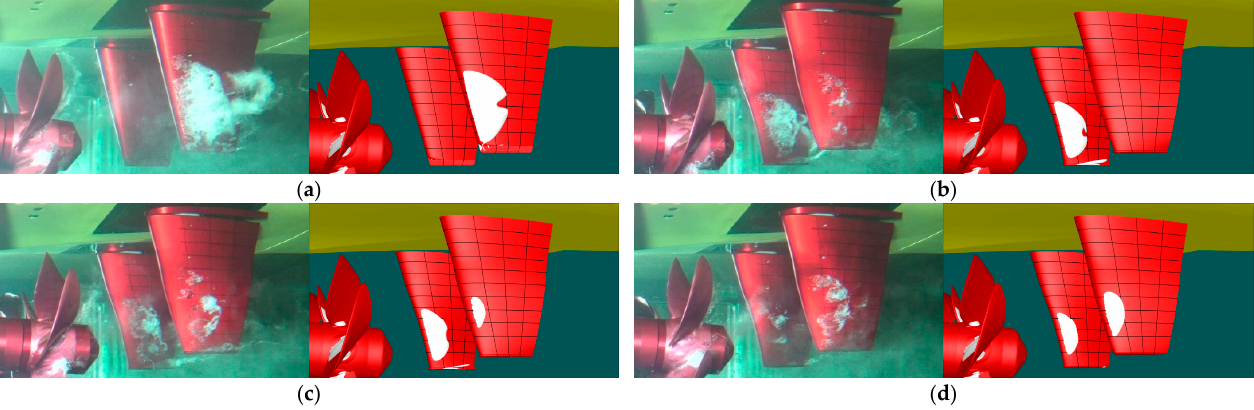
Figure 17. Experimental observation and numerical prediction of surface cavitation on the twin twisted rudders at δ R = − 8°: ( a ) flat rudder; ( b ) TR-ini; ( c ) TR-int; ( d ) TR-fin.